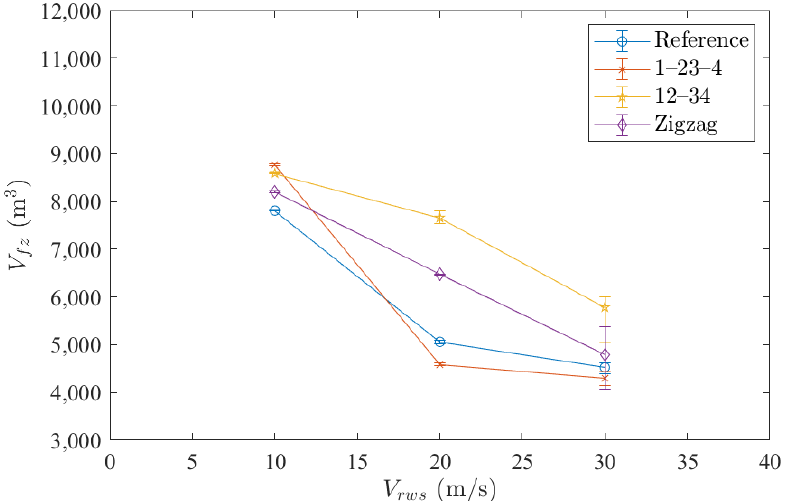
Figure 7. Total volume of the FZ ( V fz ) based on the relative wind speed ( V rws ) for each arrangement of the vent masts.